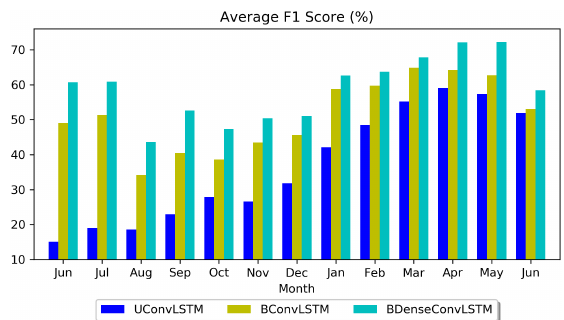
Figure 7. Overall Accuracy for Campo Verde study area, computed in each date.